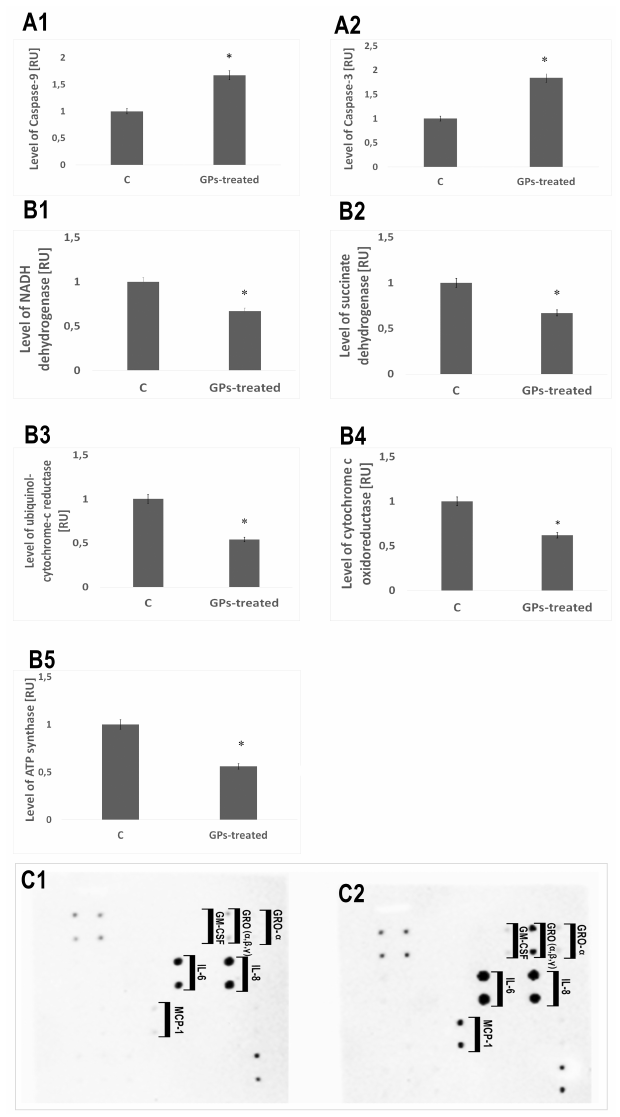
Figure 8. Protein expression level. Expression of caspase-9 and caspase-3 in the pristine graphene treated tumors significantly increased compared with the control group ( A1 , A2 ). Level of proteins involved in mitochondrial metabolism (mitochondrial respiratory chain complex: NADH dehydrogenase, succinate dehydrogenase, ubiquinol-cytochrome-c reductase, cytochrome c oxidoreductase, and ATP synthase) was significantly lower in pristine graphene treated tumors ( B1 – B5 ). A significant increase of the expression level of the protein of the following cytokines: IL-6, IL-8, GM-CSF, GRO ( α , β , γ ), MCP-1 was observed ( C1 , C2 ). Abbreviations: RU—relative